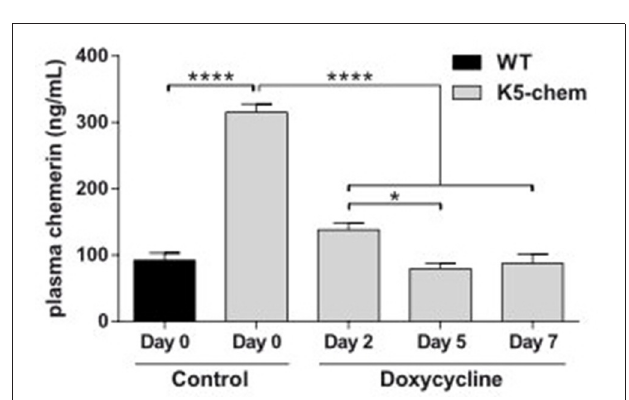
FIGURE 5 | Histology of papillomas from control and K5-chemerin mice under the DMBA/TPA protocol. Reconstitution of papilloma sections collected at week 30 of the DMBA/TPA protocol from K5-chemerin mice (left panels) and WT (right panels). Cryosections were stained with hematoxylin-eosin (A) or for CD45 (red), EGFP (green), and nuclei (Hoechst, blue) (B) .